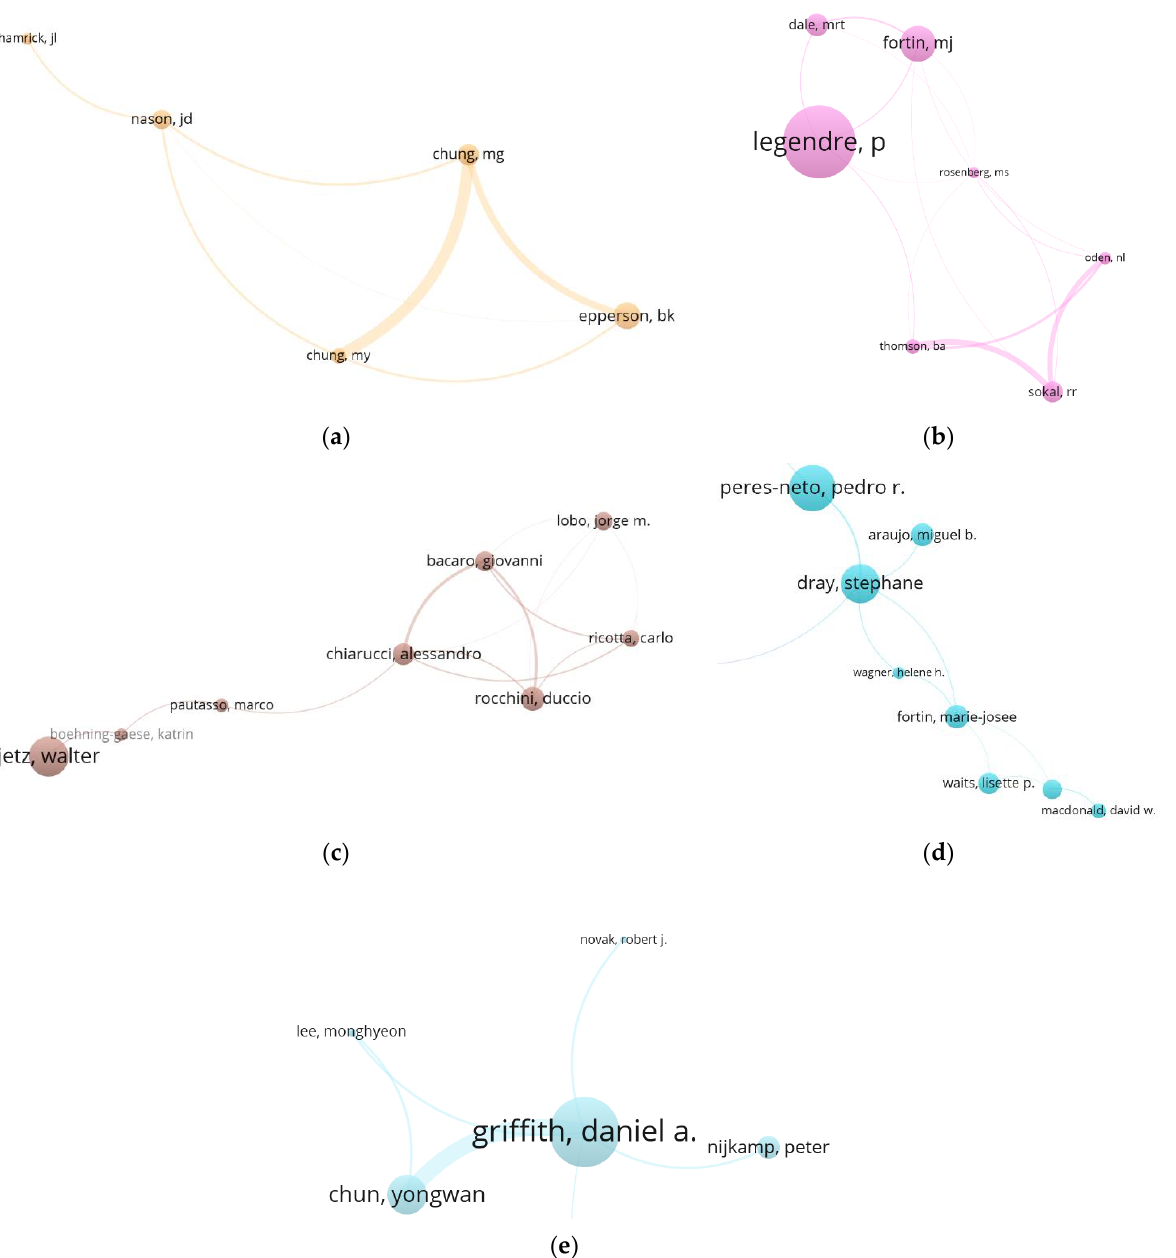
Figure 5. Five research communities in northern America: ( a ) Epperson community (Epperson, 17.69); ( b ) Legendre–Fortin community (Legendre, 50.14; Fortin, 24.72); ( c ) Jetz community (Jetz, 20.55); ( d ) Peres Neto–Dray community (Peres Neto, 30.11; Dray, 25.38); and ( e ) Griffith community (Griffith, 30.43).